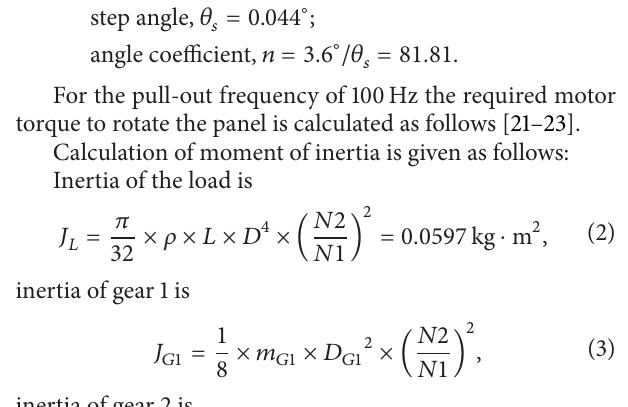
angle coefficient, 𝑛 = 3.6 ∘ /𝜃 𝑠 = 81.81